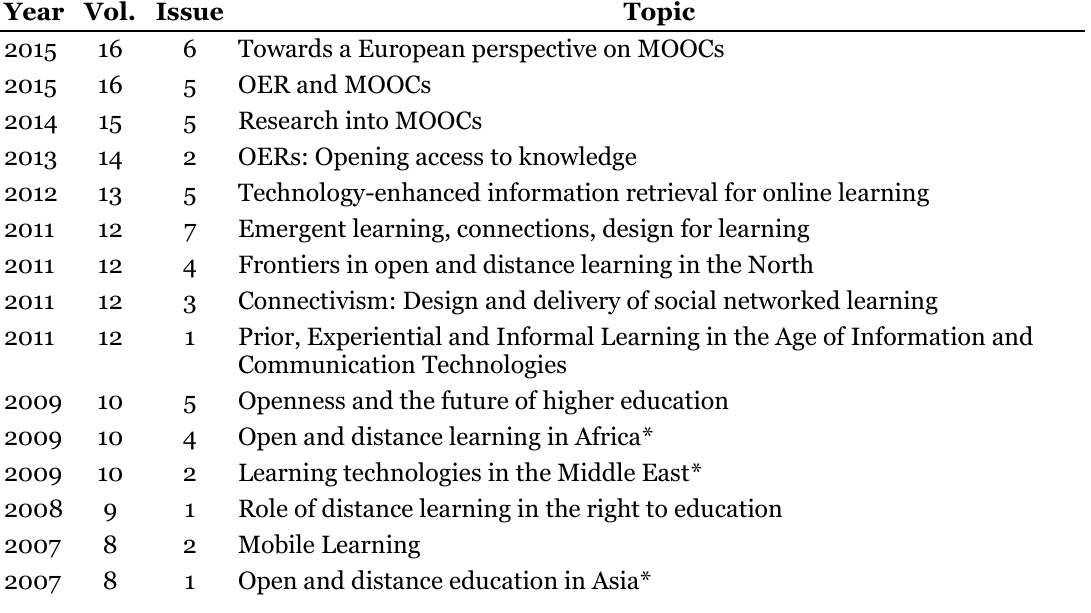
Special Issues in IRRODL by Year Year Vol. Issue Topic